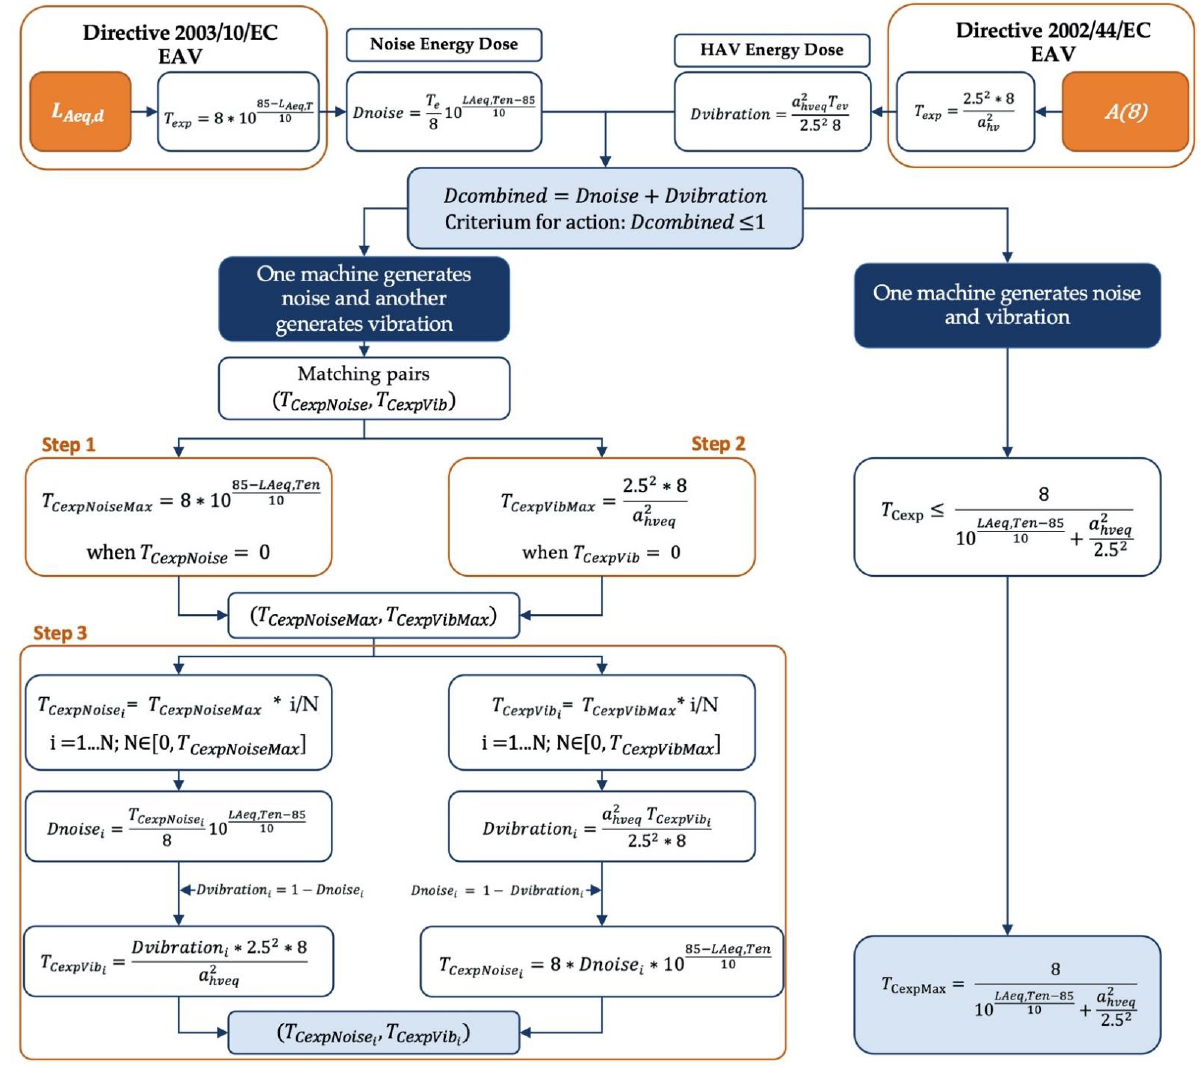
Figure 4. Flowchart of the proposed methodology.